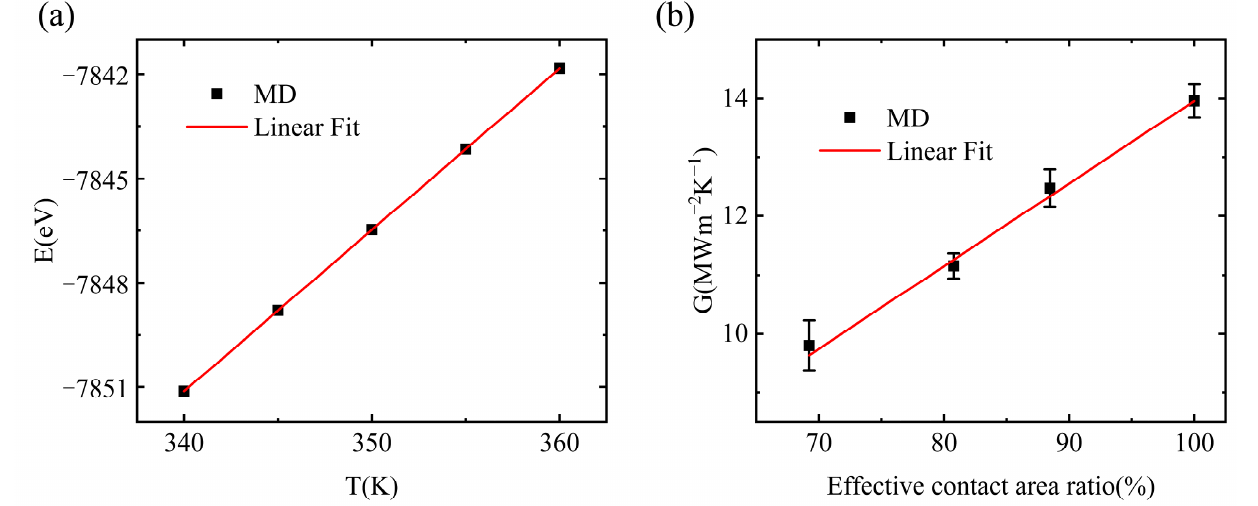
Figure 5. ( a ) The heat capacity of silicon at 350 K is calculated and linearly fitted by calculating the relationship between temperature and energy. ( b ) Relationship between the interfacial thermal conductance of single vacuole model at 400 K and the effective contact area